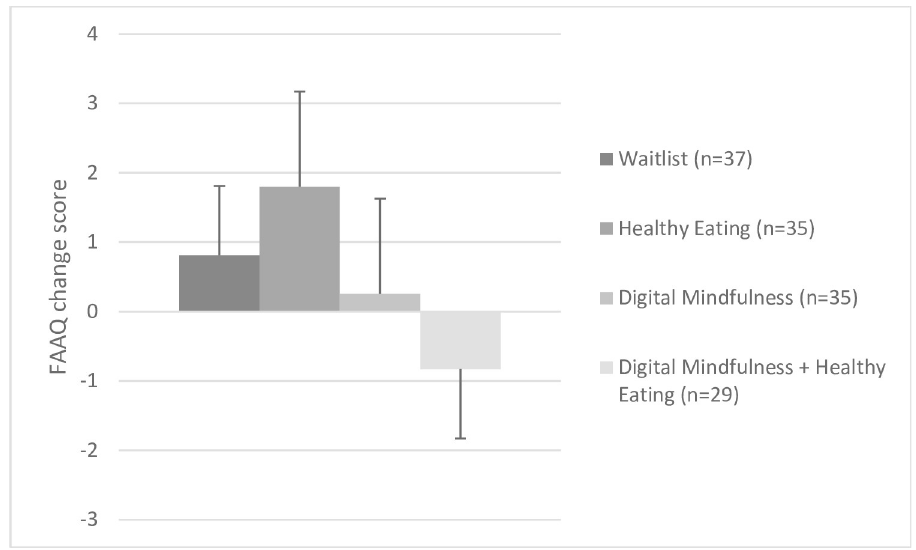
Fig 3. Effect of treatment randomization on Tolerance for Food Cravings (FAAQ) at 8 weeks, accounting for baseline values.